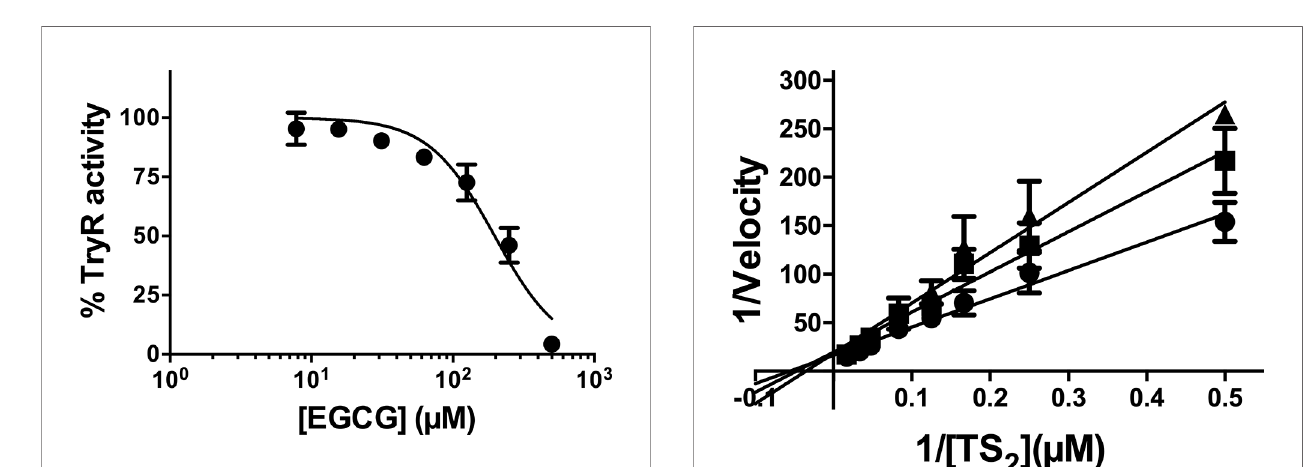
FIGURE 5 | L. infantum recombinant TR activity was inhibited by EGCG. L. infantum recombinant TR activity was assayed at 25°C and pH 7.5 in the presence of increasing concentrations of EGCG (7.8 – 500 µM), and the assays were carried out in triplicate. Control experiments were carried out in the absence of the inhibitor. Values represent mean ± standard error of three different experiments run in triplicate.